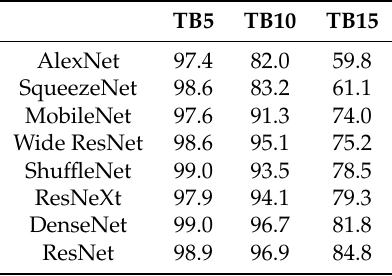
Table 10. Free-space TB5-10 inter-set test. Architectures trained on TB5-10 and tested against all TB data sets.